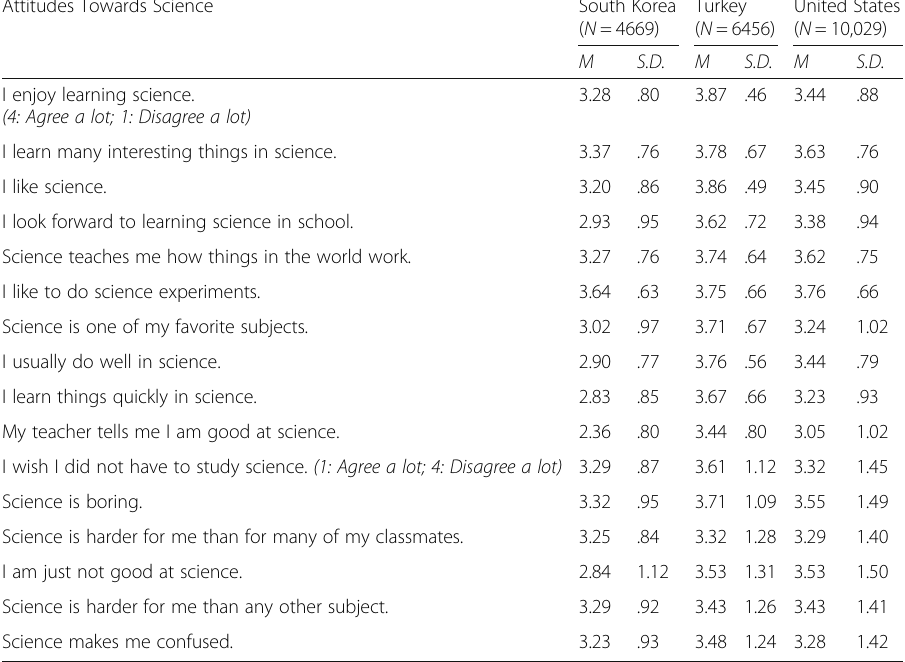
Table 4 Descriptive statistics of fourth graders ’ attitudes towards science in South Korea, Turkey, and the United